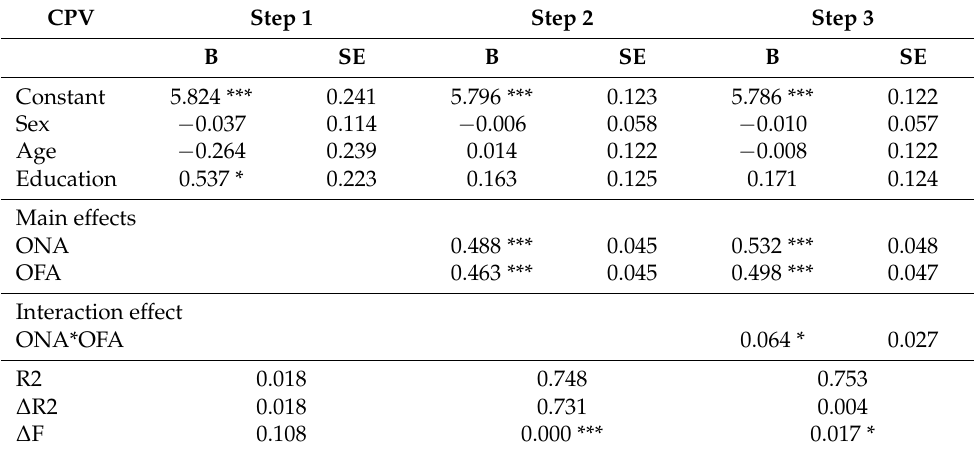
Table 8. Results of interaction effect of ONA and OFA on